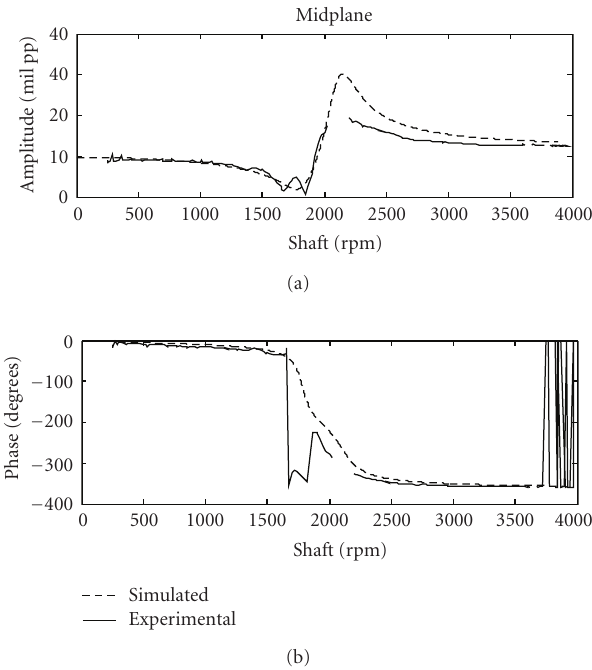
Figure 14: Synchronous response of a bowed rotor at midplane disk. Ro = .64, ao = 180 ◦ . Drop out of data near 2000 rpm is due to displacement exceeding transducer range. Phase wrap evident in the experimental plot around 1700 rpm and above 3500 rpm is due to software that adds 360 ◦ for phase ranges beyond 360 ◦